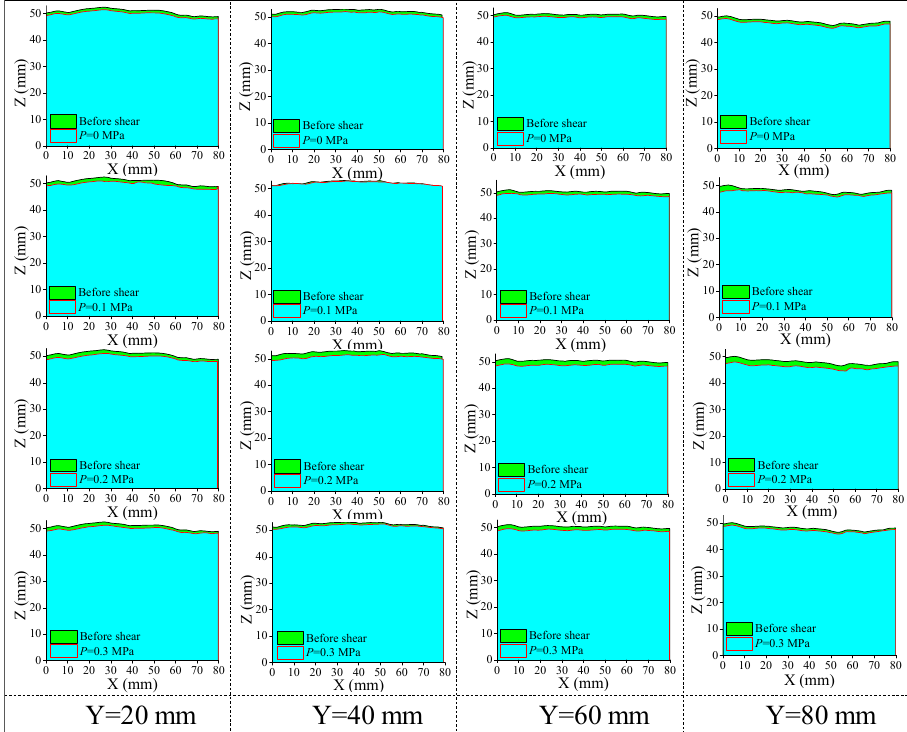
Figure 7. Contour line of the structural plane at different Y values. As seepage water pressure increased, the 2D section line shape of the structural plane remained consistent. However, the height of the section line decreased slightly, indicating that the surface layer of the structural plane peeled off due to shear friction. Compared with its value before shearing, the JRC value of the structural plane section decreased; thus, the roughness of the structural plane was reduced, indicating that the surface of the structural plane became smooth. The JRC value of the section line increased gradually with the increase of the seepage water pressure, indicating that the damage degree of the structural plane increased gradually.